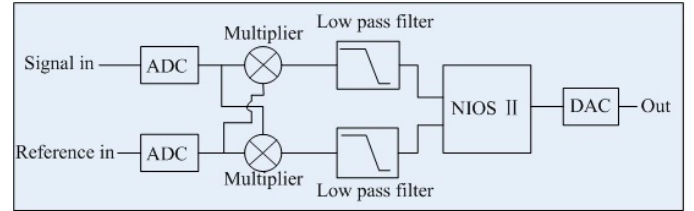
Figure 5. Schematic diagram of the FPGA based lock in amplifier.